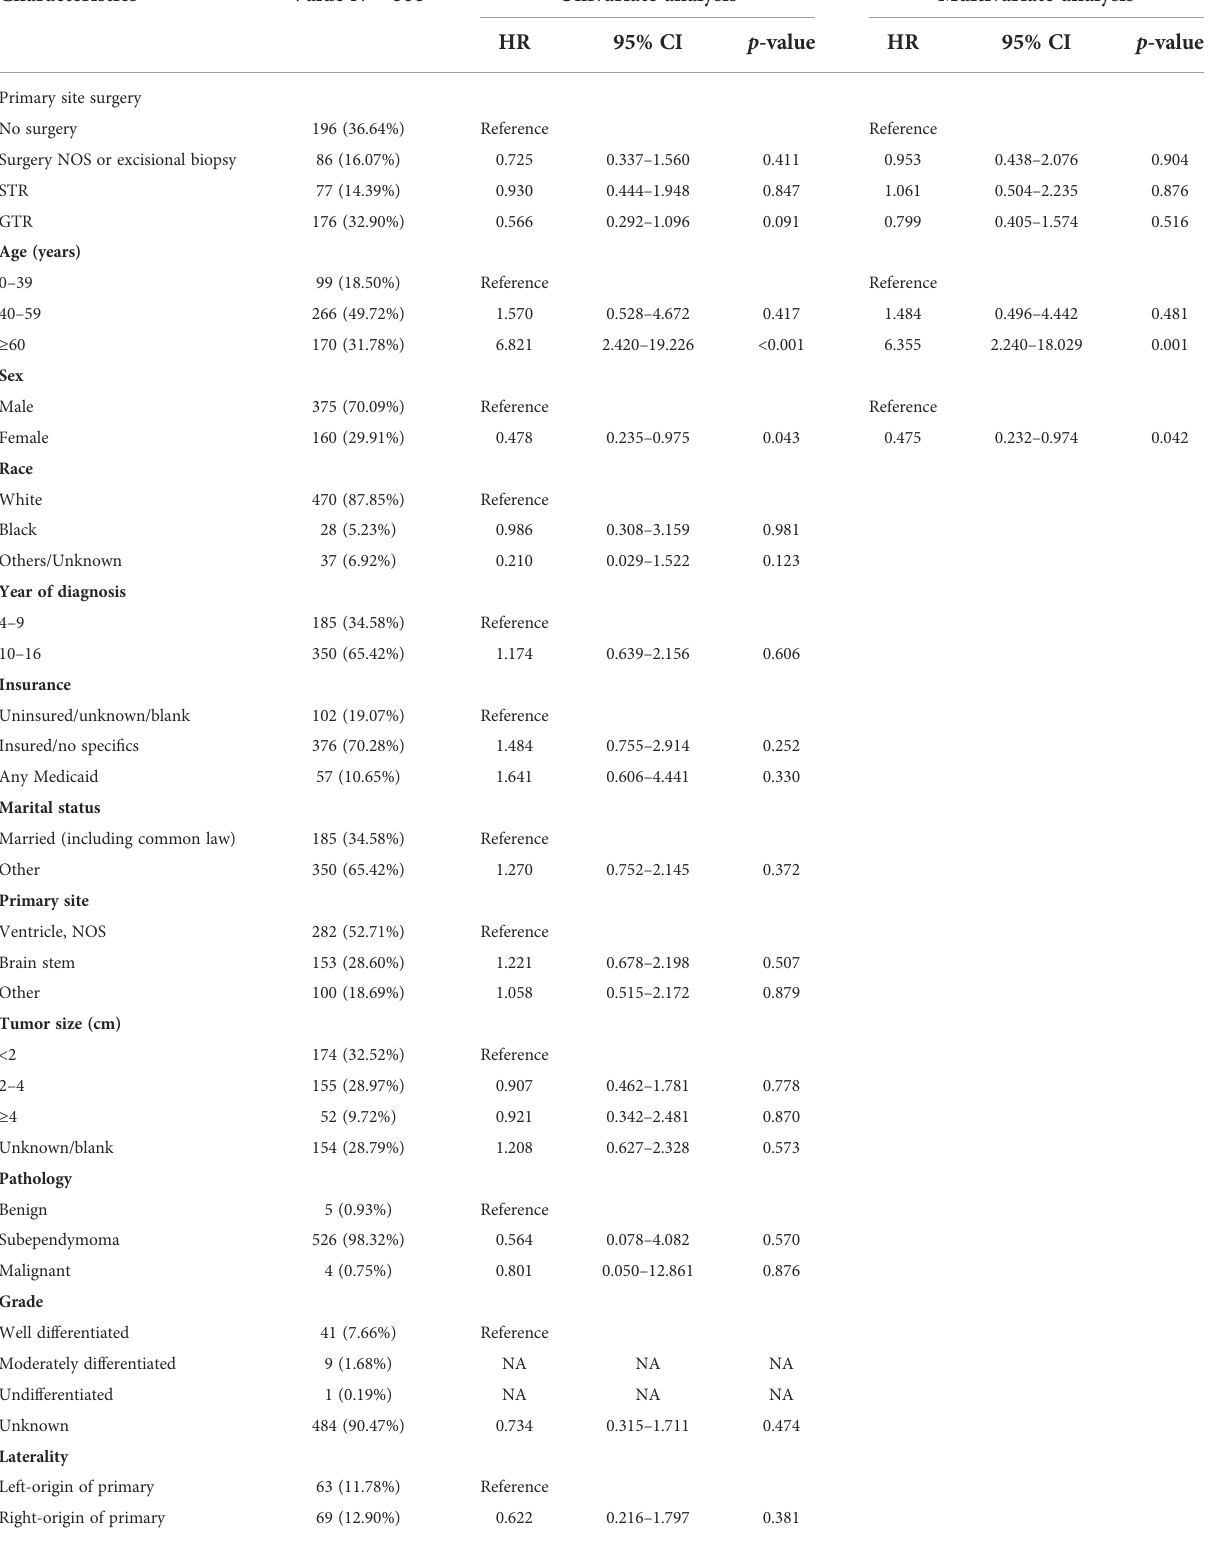
TABLE 2 Training cohort